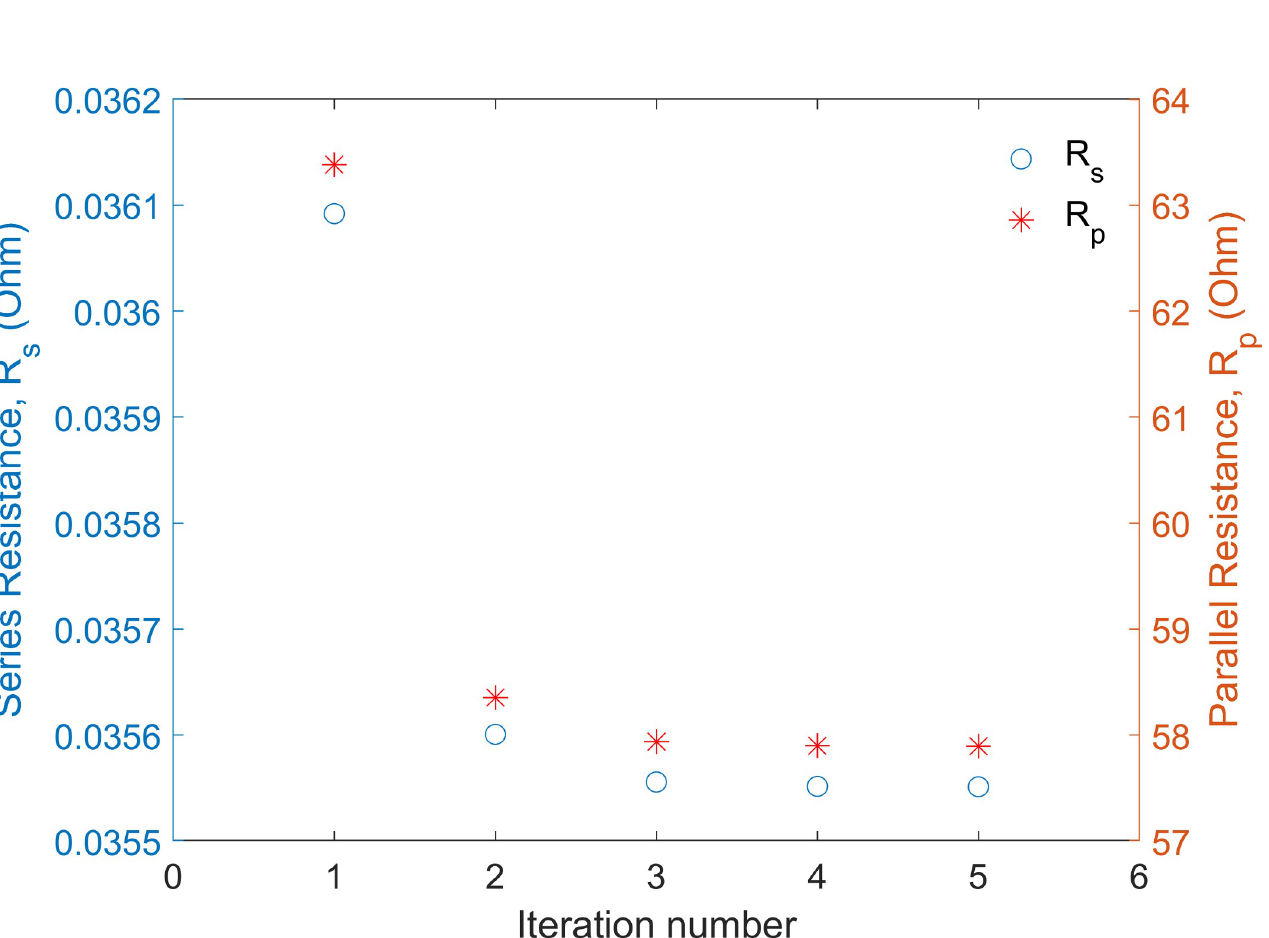
Fig 2. The change in values of R s and R p within five loop iterations, the final fixed values are used in ACT approach for the parameters extraction.